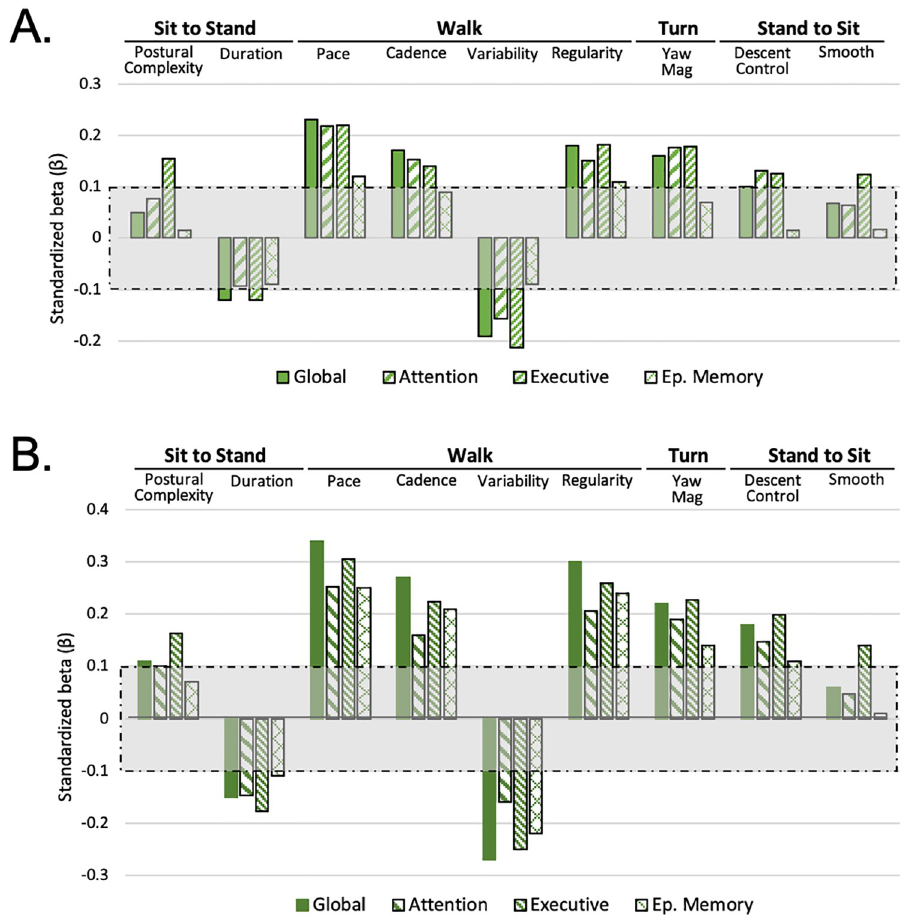
Fig 3. Quantitative TUG vs. individual cognitive domains. Associations between TUG subtasks and individual cognitive abilities during (a) normal and (b) dual-task (dark green) conditions, after adjusting for age, sex, race, and education. A standardized beta ( β ) beyond the [-0.10, 0.10] shaded box corresponds to p < .005, while a β beyond [-0.133, 0.133] corresponds to p < .0001.